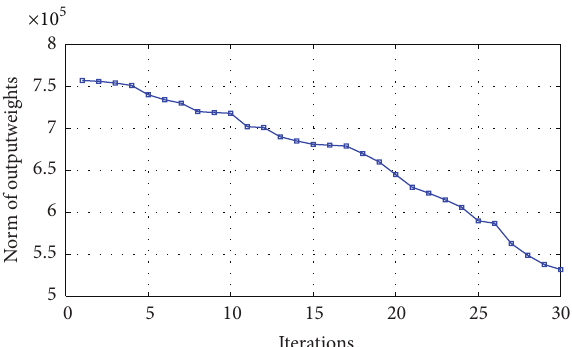
Figure 9: Mean evolution of output weight norm of our